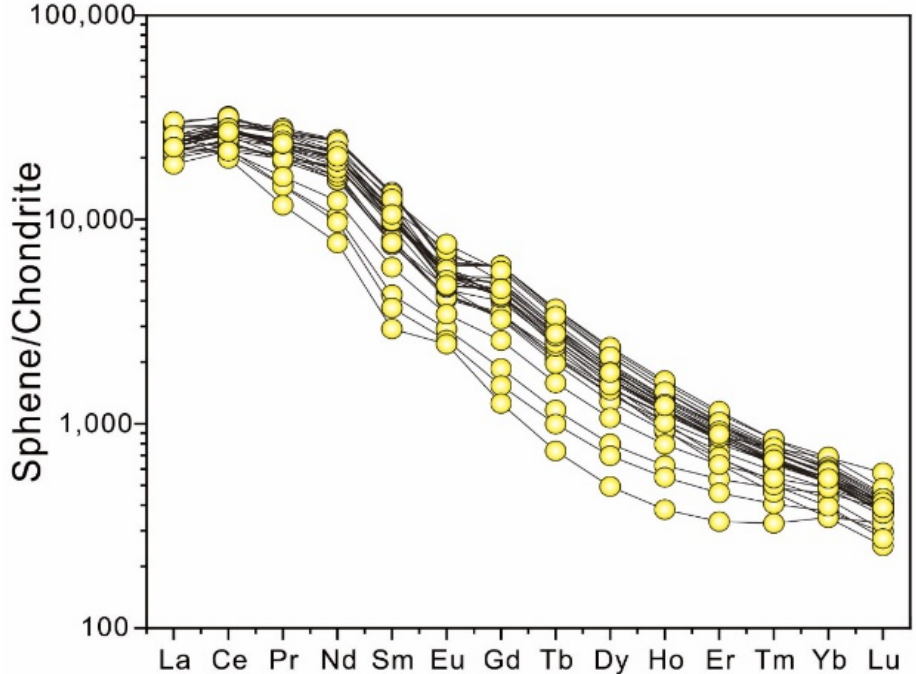
Figure 5. Chondrite‑normalized REE patterns of sphene from the hornblende diorite (21LBS27) of Figure 5. Chondrite-normalized REE patterns of sphene from the hornblende diorite (21LBS27) of the Longbaoshan alkaline complex. Chondrite values are from the Longbaoshan alkaline complex. Chondrite values are from [59].